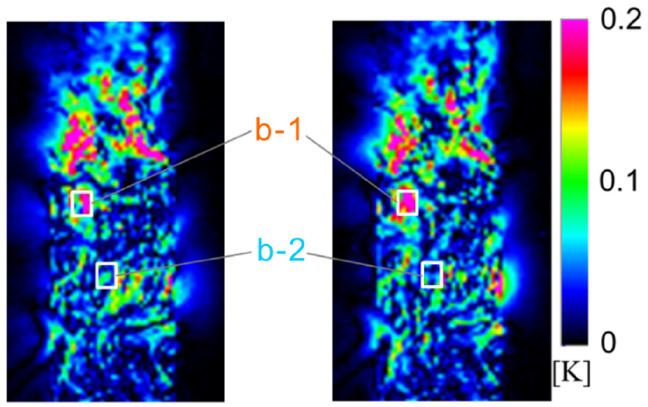
Figure 7. Distribution of second harmonic temperature component for Specimen B.